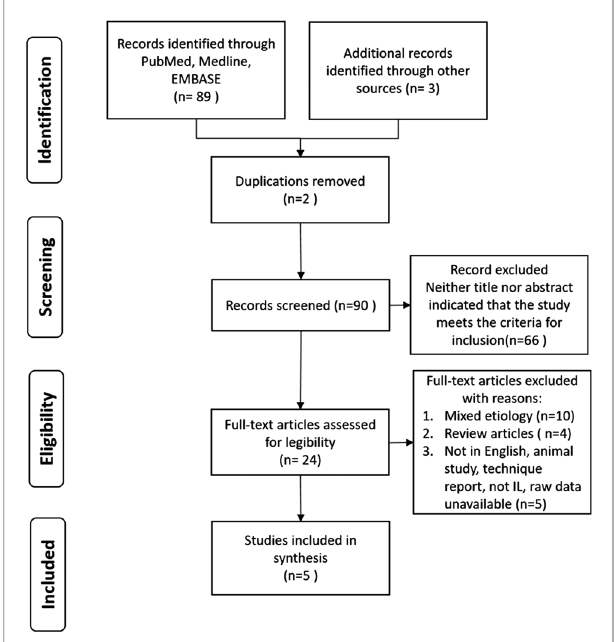
FIGURE 1 | PRISMA fl ow diagram depicts the process of literature